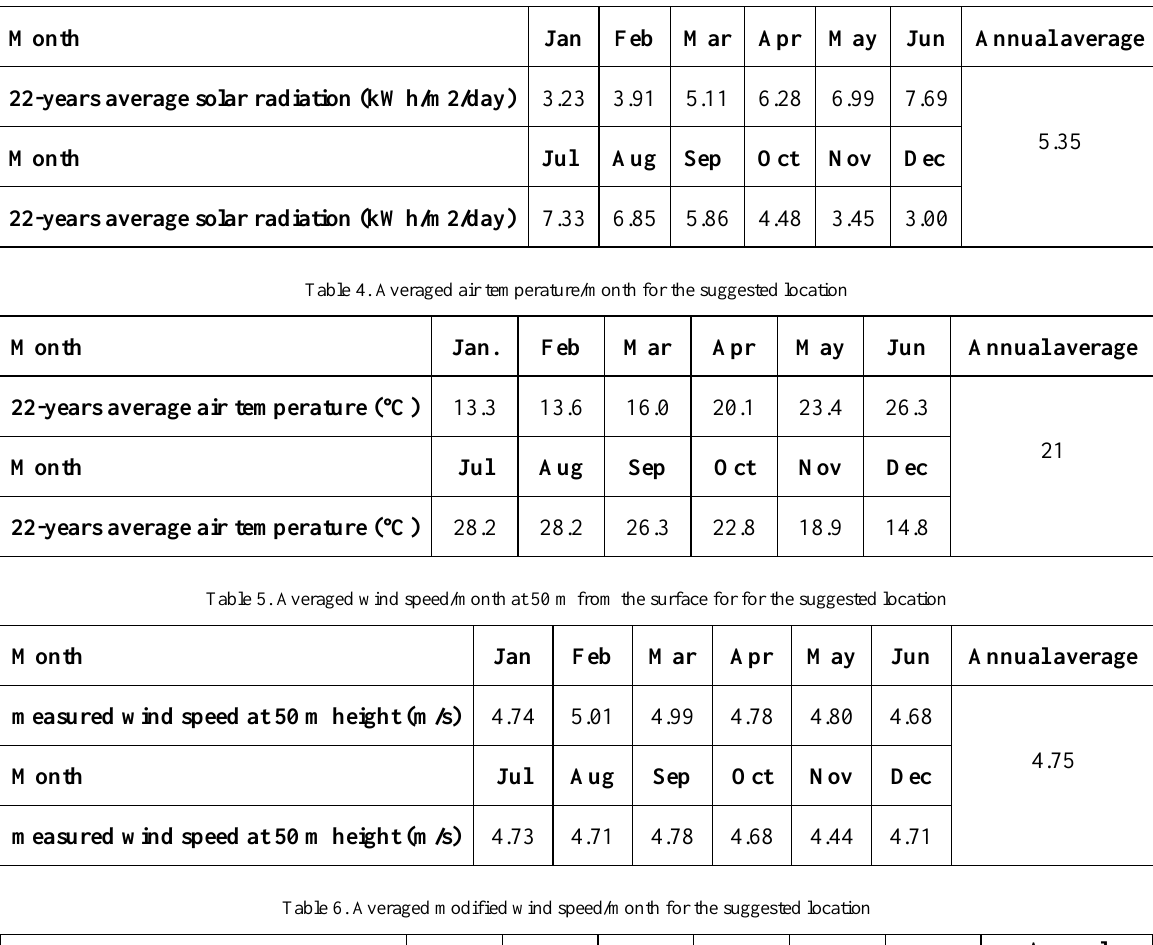
Table 3. Monthly averaged isolation for the suggested location